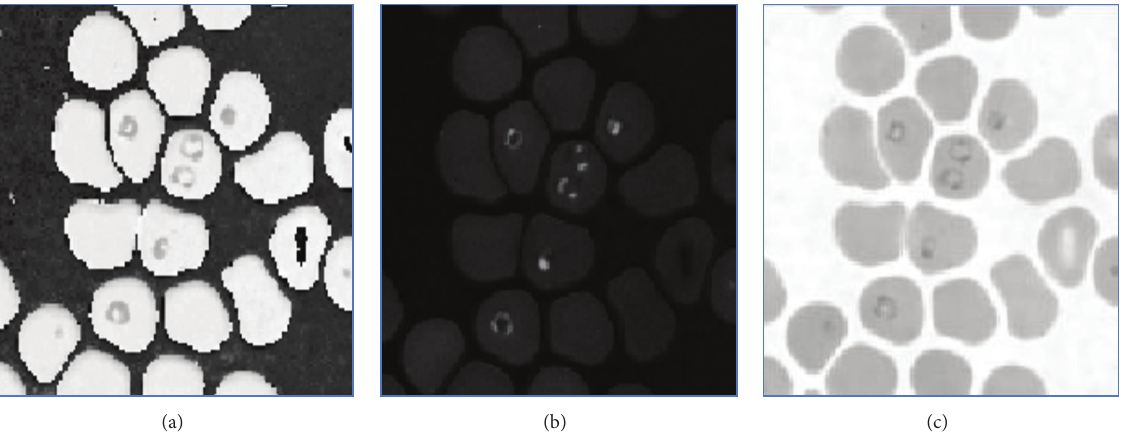
Figure 4: Separated HSV bands: (a) H band, (b) S band, and (c) V band.